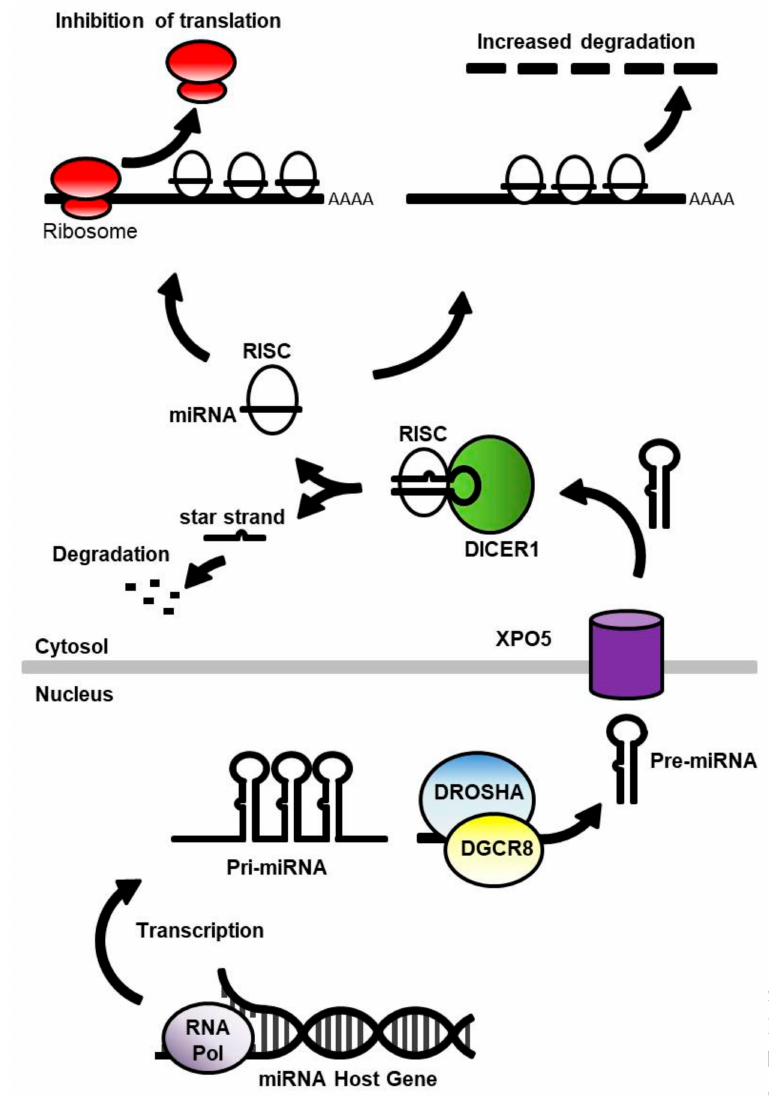
Figure 1. A schematic of microRNA (miRNA) processing and function. miRNA is initially synthesised as a primary (pri-) miRNA gene product containing 1–6 repeat sequences of the precursor (pre-) miRNA, which consists of the mature miRNA sequence connected to the complementary (star) strand by a hairpin loop. The pre-miRNA is cleaved from the pri-miRNA transcript by the DROSHA/DGCR8 enzyme complex and shuttled out of the nucleus by XPO5. The hairpin loop is cleaved from the pre-miRNA by DICER1, and the miRNA is loaded into the RNA-induced silencing complex (RISC), where the star strand is removed, allowing the mature miRNA to bind to the target messenger RNA (mRNA). The miRNA is able to inhibit protein synthesis by obstructing translation by the ribosome or flagging the mRNA for degradation. Abbreviations: DGCR8, DiGeorge syndrome chromosomal region 8; DICER1, endoribonuclease dicer; DROSHA, drosha ribonuclease III; XPO5, exportin-5; RNA Pol, RNA